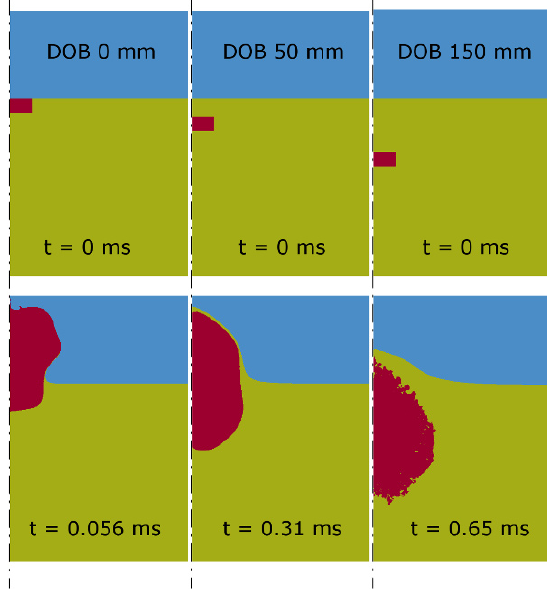
Figure 16. Explosion behaviour at different burial depths (DOB). Upper picture shows the explosive (red), soil (brown) and air (blue) prior to detonation. Lower picture shows the material expansion at the time when the shock wave reaches the top boundary at 250 mm from the ground